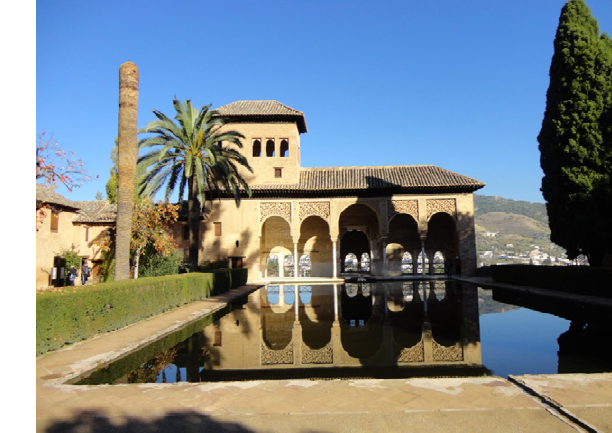
Figure 3. Water pool at Alhambra’s Generalife Figure 4. Water mirror images in